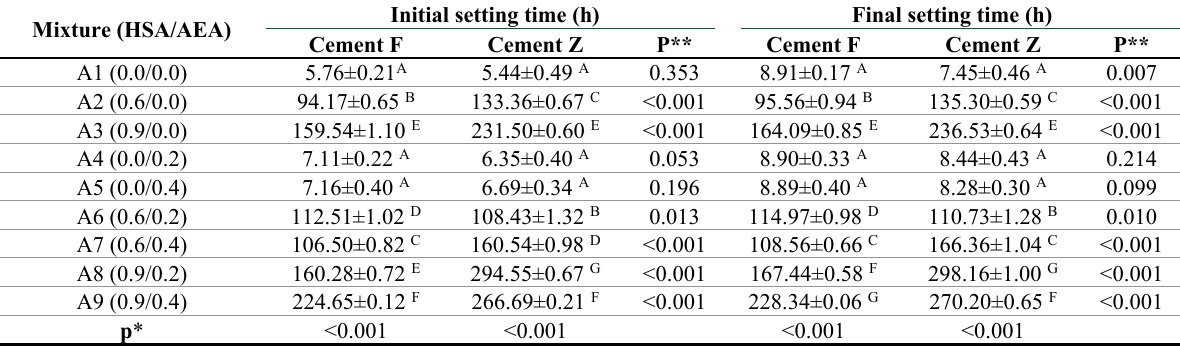
Table 7. Mortar setting time (M±SD) using cements F and Z, by the direct fraction method. Mixture (HSA/AEA)